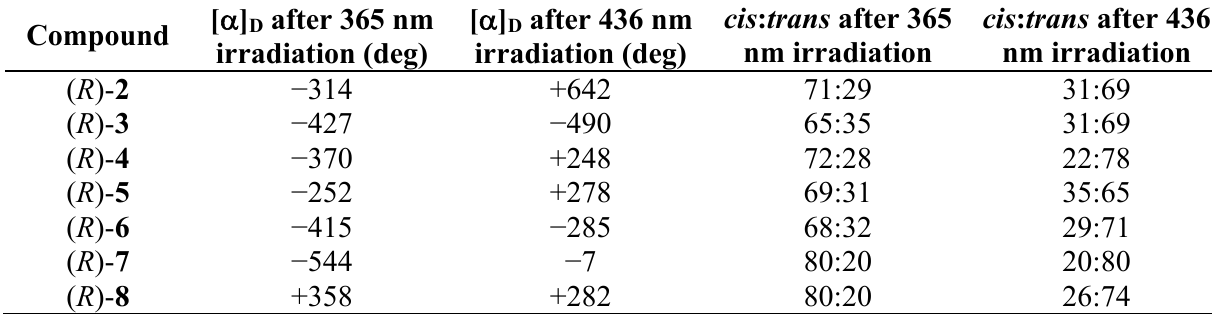
Table 1. [ α ] and cis - trans ratio after photoirradiation of ( R )- 2 - 8 . D Compound